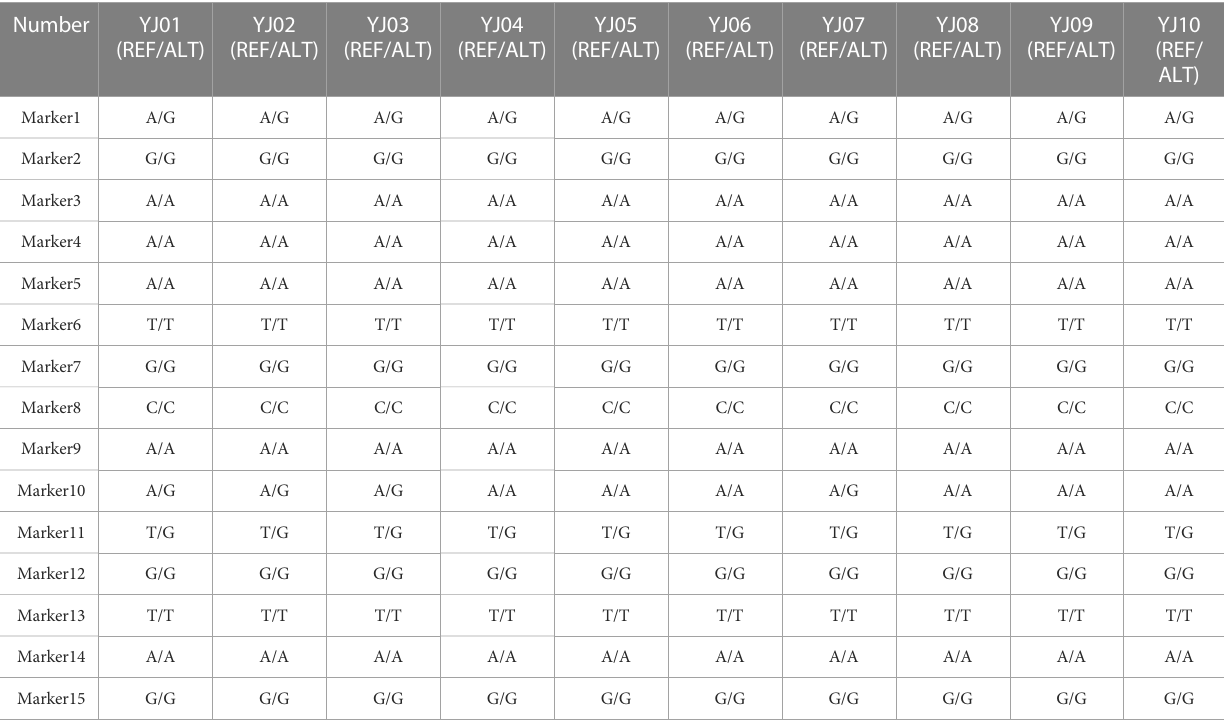
TABLE 6 L. japonica genetic stability